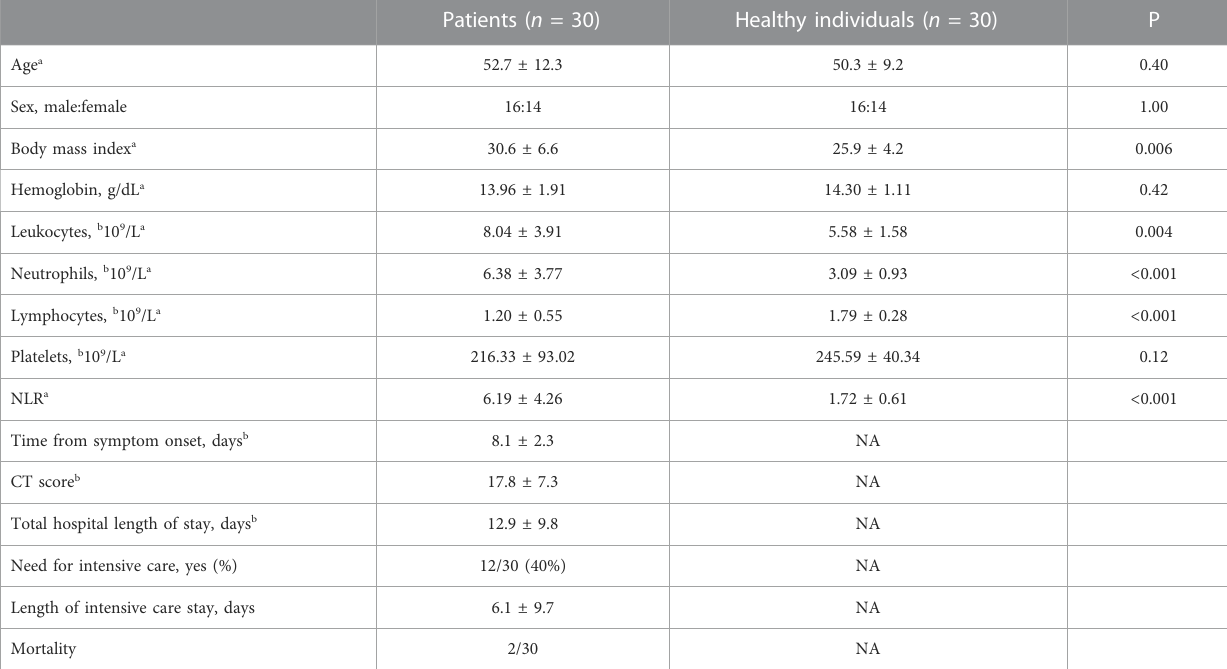
TABLE 1 Clinical and laboratory characteristics of the study